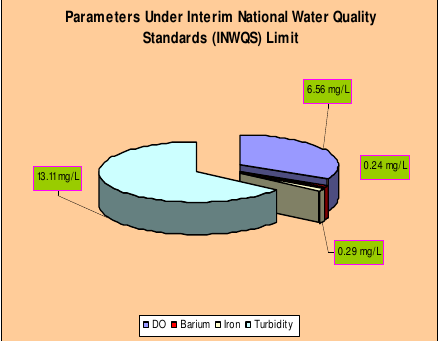
Figure 15. Parameters under Safe Water Quality Limits.